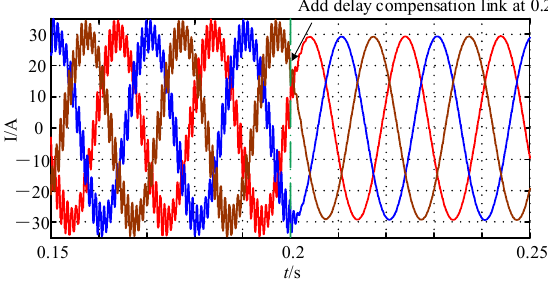
Figure 11. Switching of delay compensation link in weak grid.